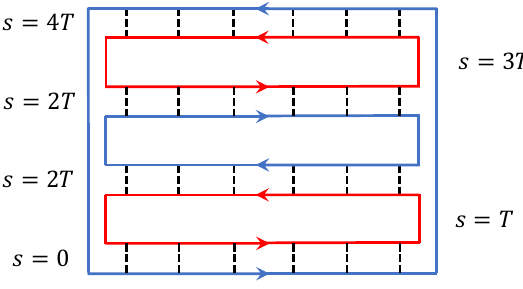
Figure 7 . A schematic labeling of the contour. The blue (red) line indicates the subregion A (B). The dashed line indicates couplings between the two regions. The arrow denotes the real time (unitary)